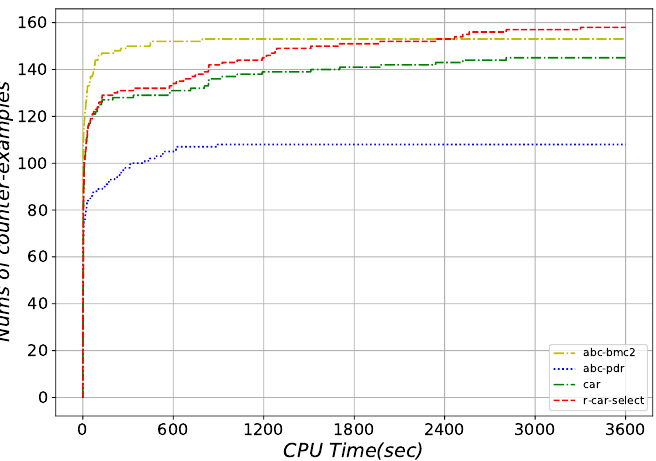
Figure 6. The overall performance of CAR, r-CAR, BMC, and PDR. It should be clarified that r-CAR with a single configuration cannot outperform